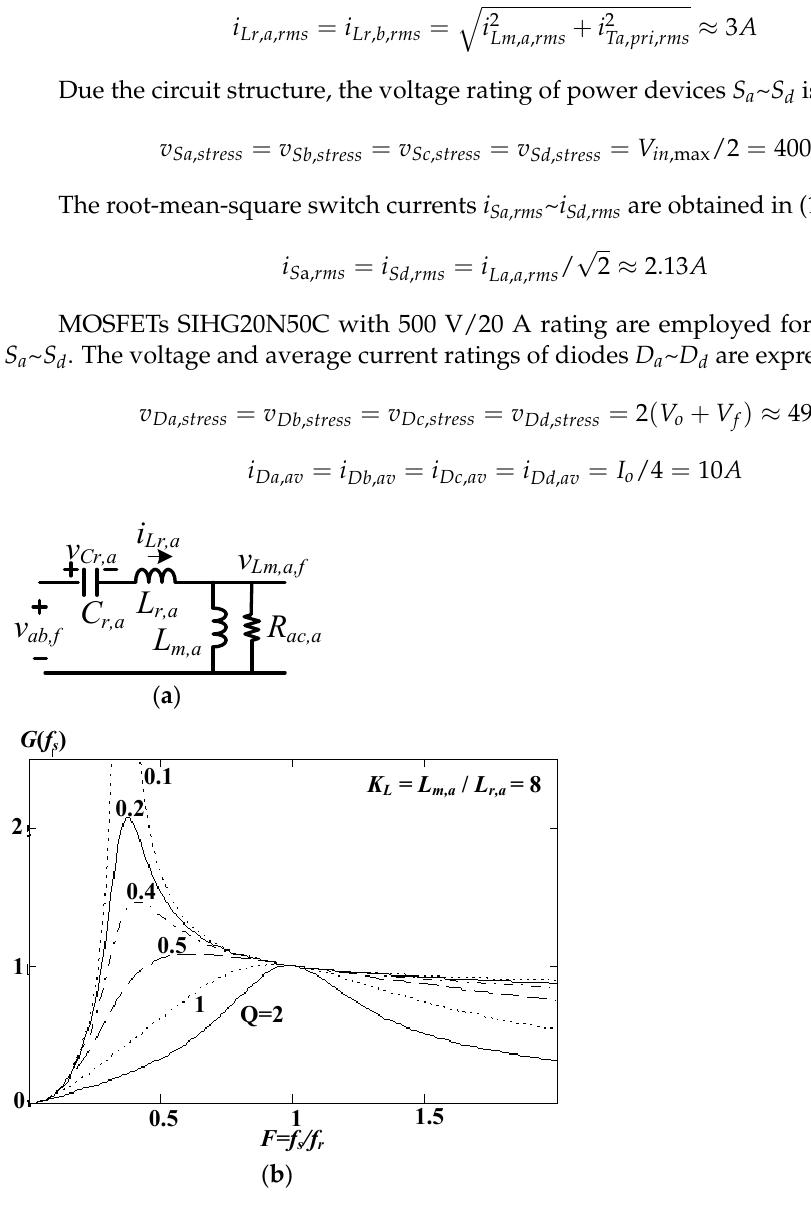
Figure 6. The ac resonant tank and voltage gain ( a ) resonant tank on primary-side of resonant circuit 1 and ( b ) converter voltage gain.